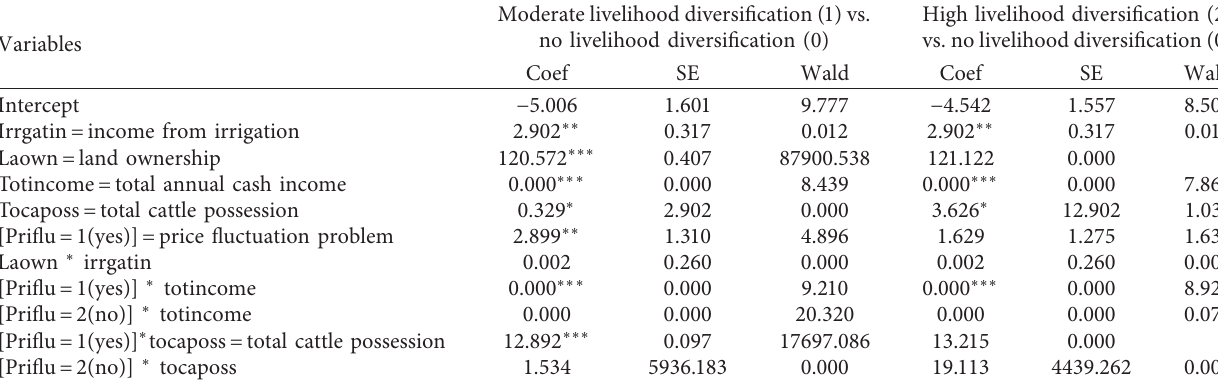
Table 2: Summary of multinomial logistic regression model analysis.